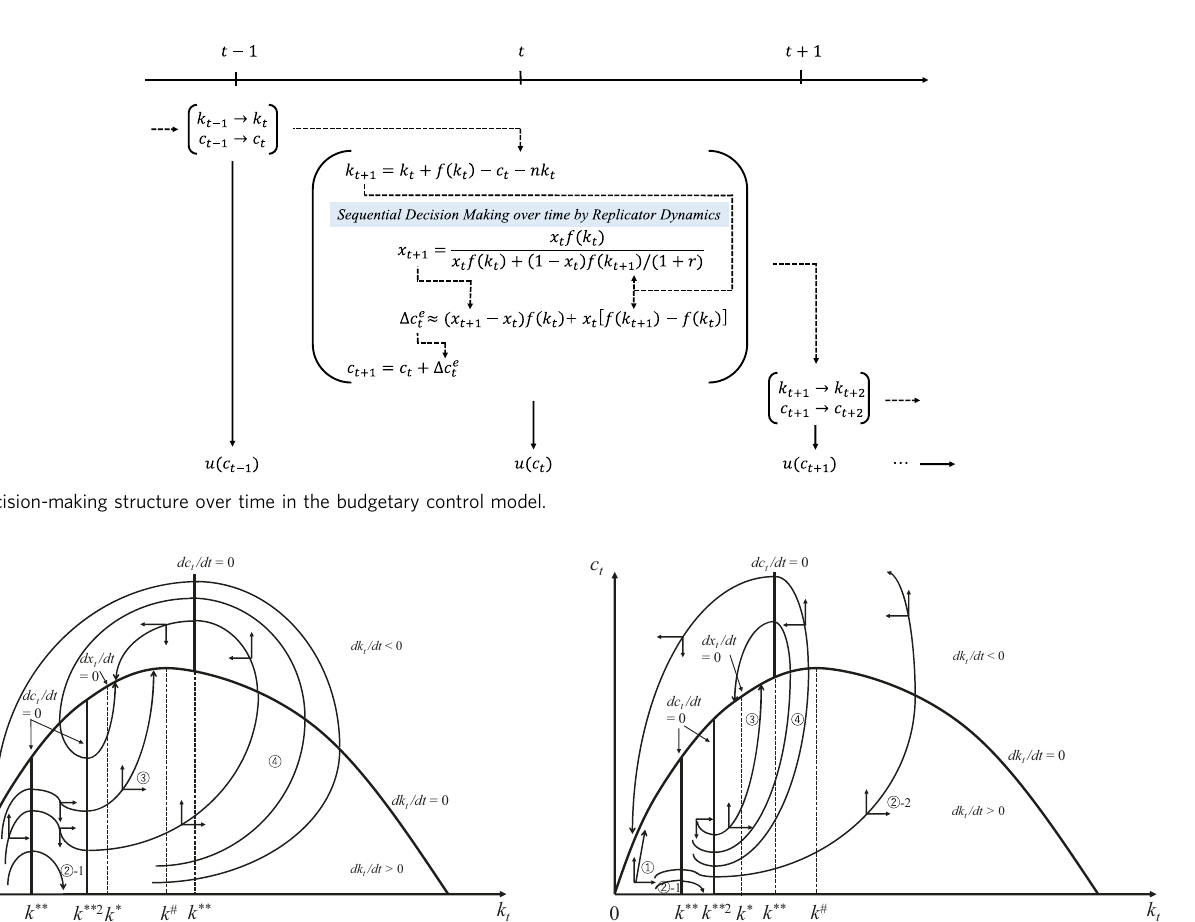
(cid:8) Fig. 5 Budget-controlled growth path in the case of k ** _ k t < 0